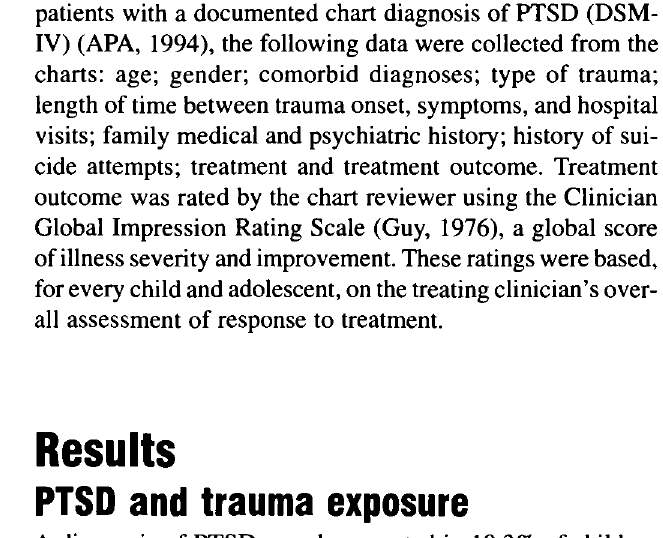
Table I: Axis II, III and IV diagnoses for PTSD subjects AXIS